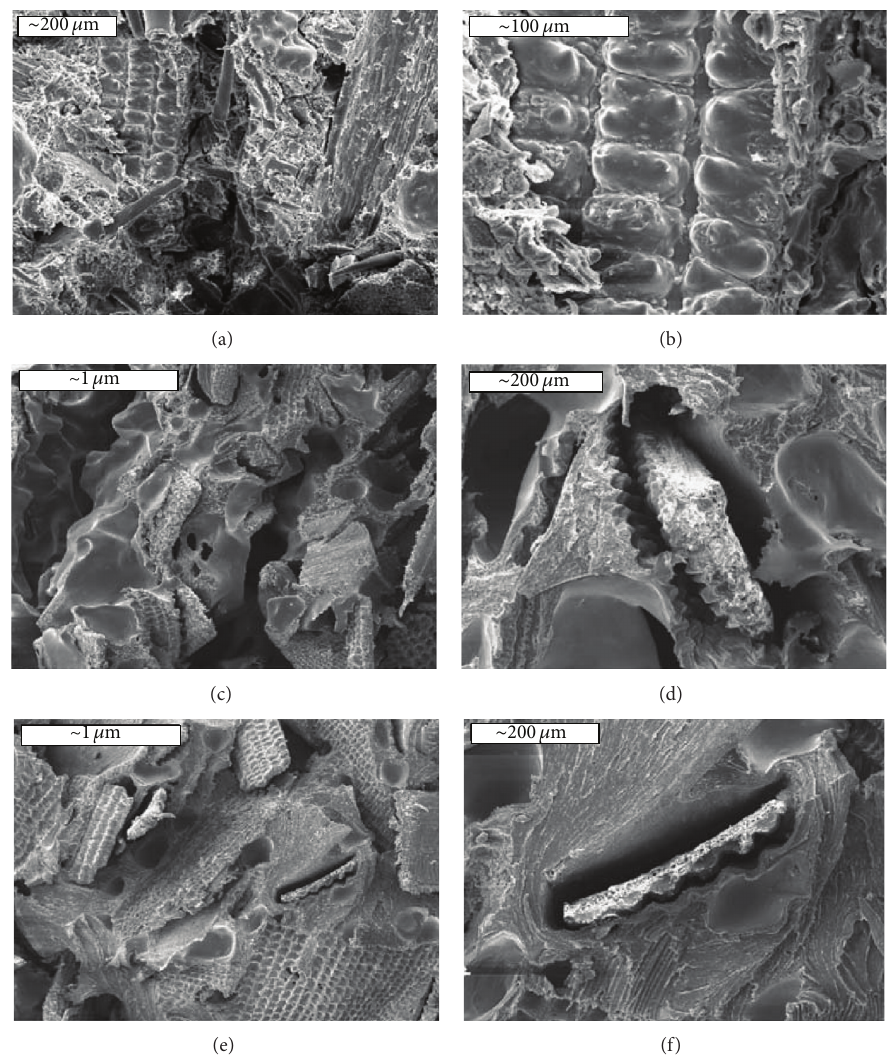
Figure 24: SEM micrographs of plasticized PVC containing 20wt% RH filler with different plasticizer and particle size: (a) 40phr, 150 𝜇 m, × 150; (b) 40phr, 150 𝜇 m, × 500; (c) 60phr, 500 𝜇 m, × 50; (d) 60 phr, 500 𝜇 m, × 150; (e) 60 phr, 1000 𝜇 m, × 50; and (f) 60 phr, 1000 𝜇 m, × 150